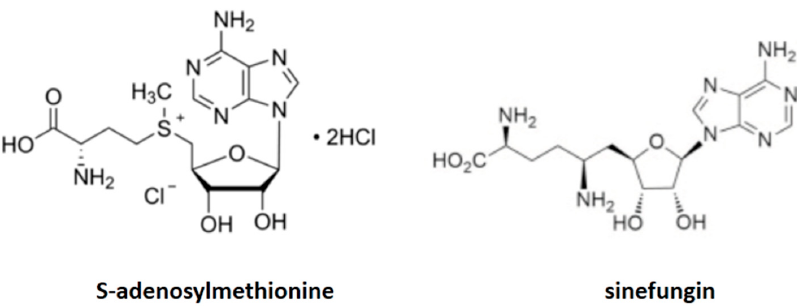
Figure 2. Comparative structures of S -adenosylmethionine and sinefungin.